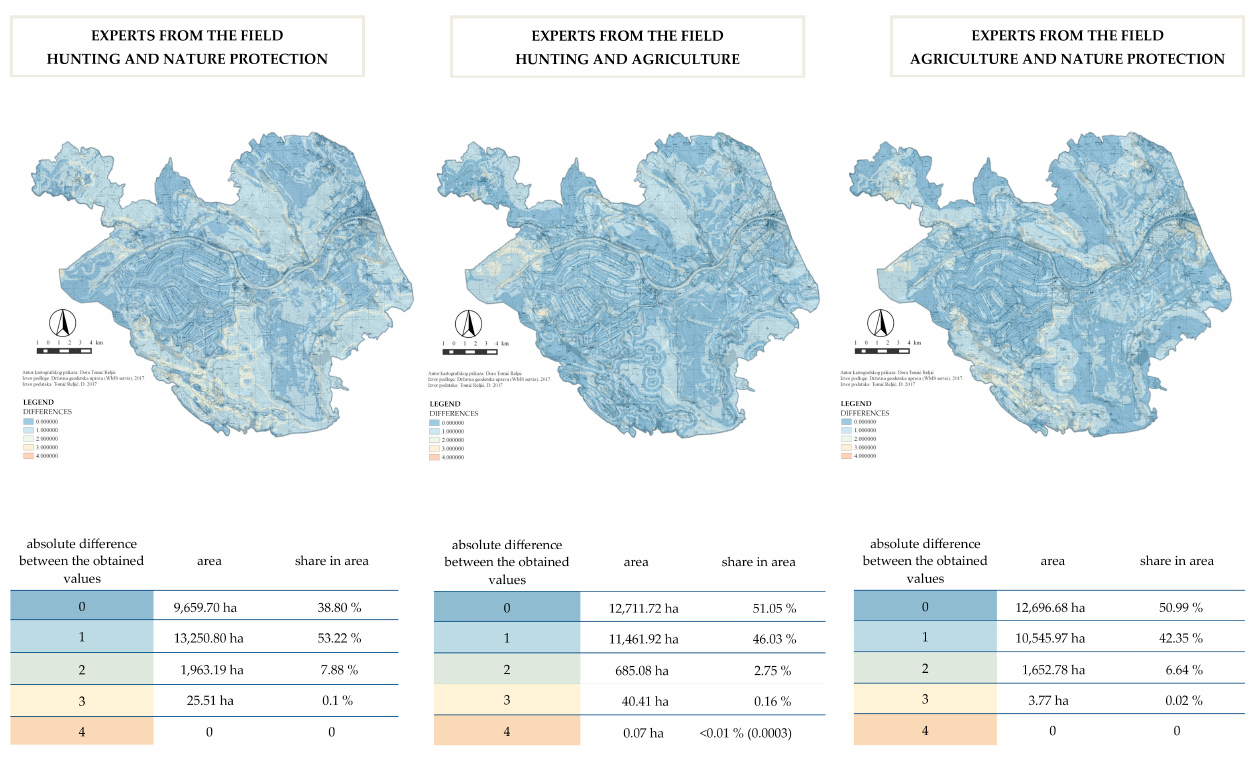
Figure 9. Differences between obtained values .